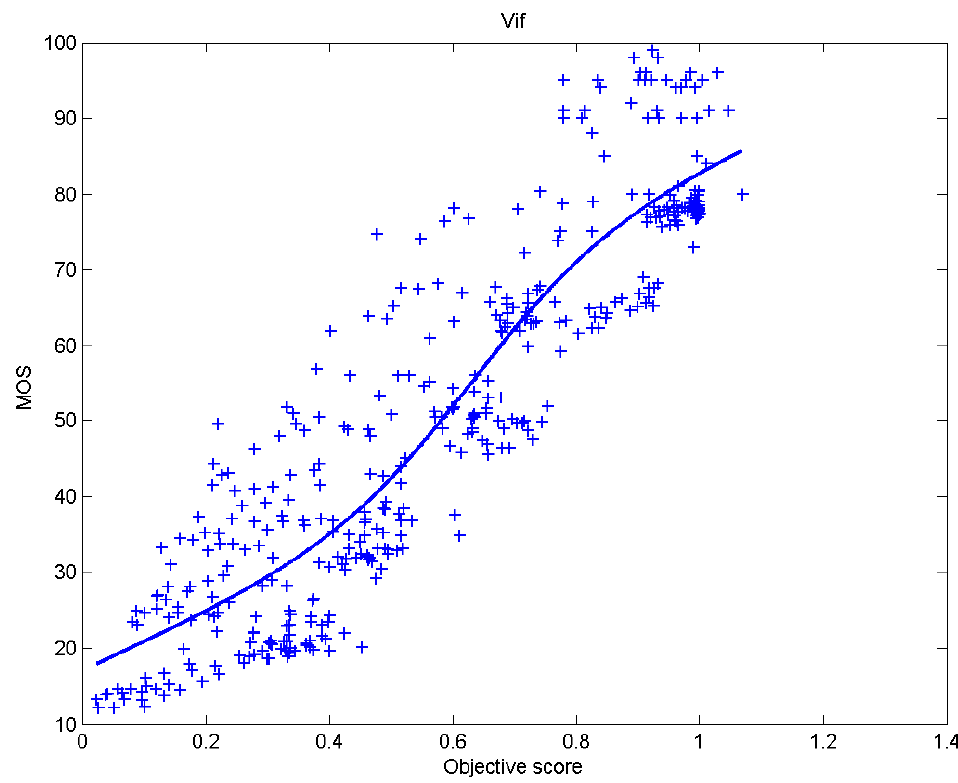
Figure 20. Scatter plots of the subjective scores (MOS) vs. VIF.